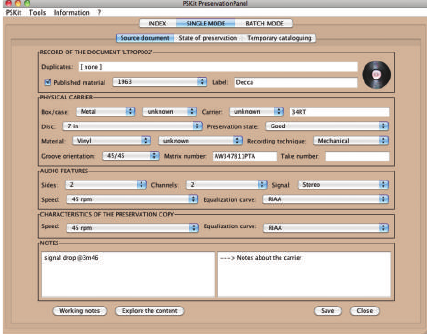
Figure 11: Panel for the description of single documents in PSKit PreservationPanel for the carrier type “phonographic